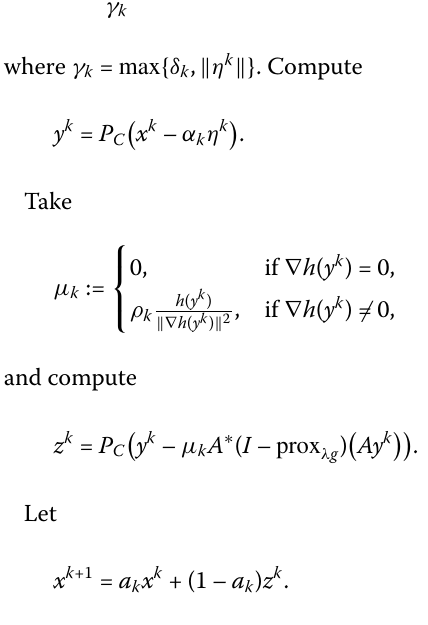
f ( x k , x k ) and 2